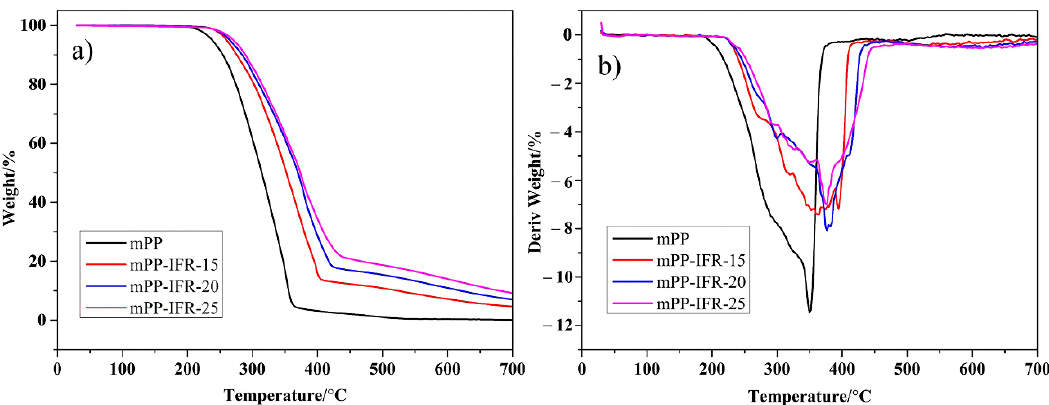
Figure 10. TG curves ( a ) and DTG curves ( b ) of the fibers in air atmosphere.